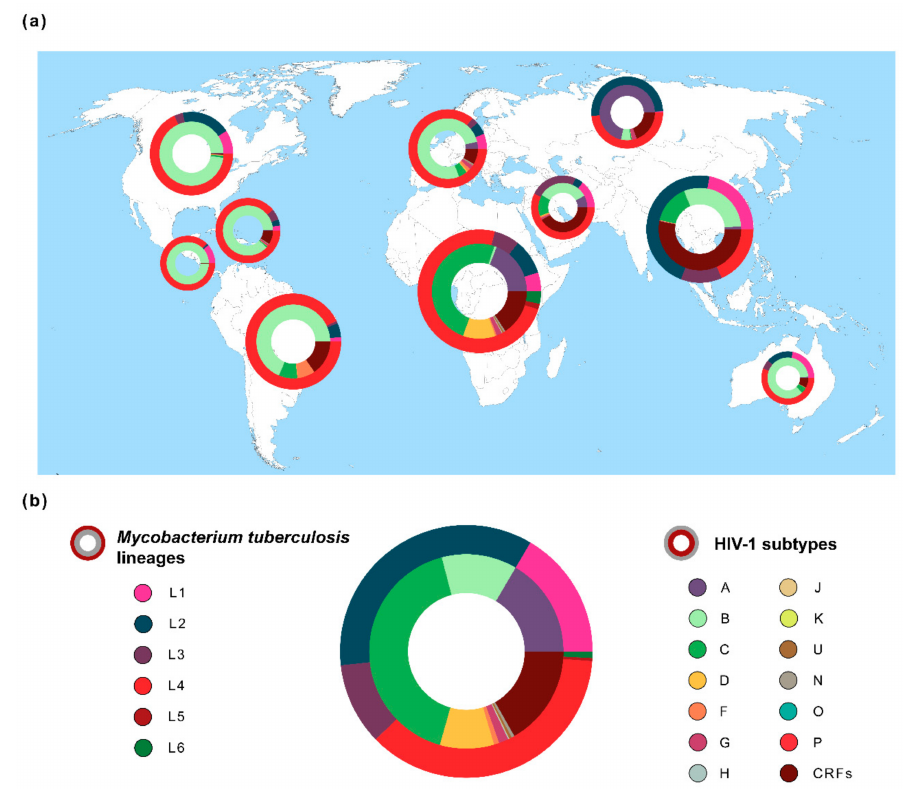
Figure 1. Global distribution of the genetic diversity of Mycobacterium tuberculosis and Human Immunodeficiency Virus typ1 1 (HIV-1). ( a ) Frequencies of M. tuberculosis lineages (outer ring/circle) and HIV-1 subtypes (inner ring/circle) across 10 geographic regions. Pie chart size is related with both diseases’ prevalence in each region [1,3]. Geographic regions are according to Los Alamos HIV database (http://www.hiv.lanl.gov/) [25]. M. tuberculosis spoligotype clades ( n = 64,555 sequences) were extracted from the SITVIT2 database [49] and converted to Mycobacterium tuberculosis complex (MTBC) lineages 1–6 [45,50,51]. HIV-1 data ( n = 815,431 sequences) were obtained from Los Alamos HIV database [25]. ( b ) Global frequency of M. tuberculosis lineages and HIV-1 subtypes. The estimated number of people living with TB or HIV-1 was obtained from the World Health Organization (WHO) [1] or from the Joint United Nations Programme on HIV/AIDS (UNAIDS)